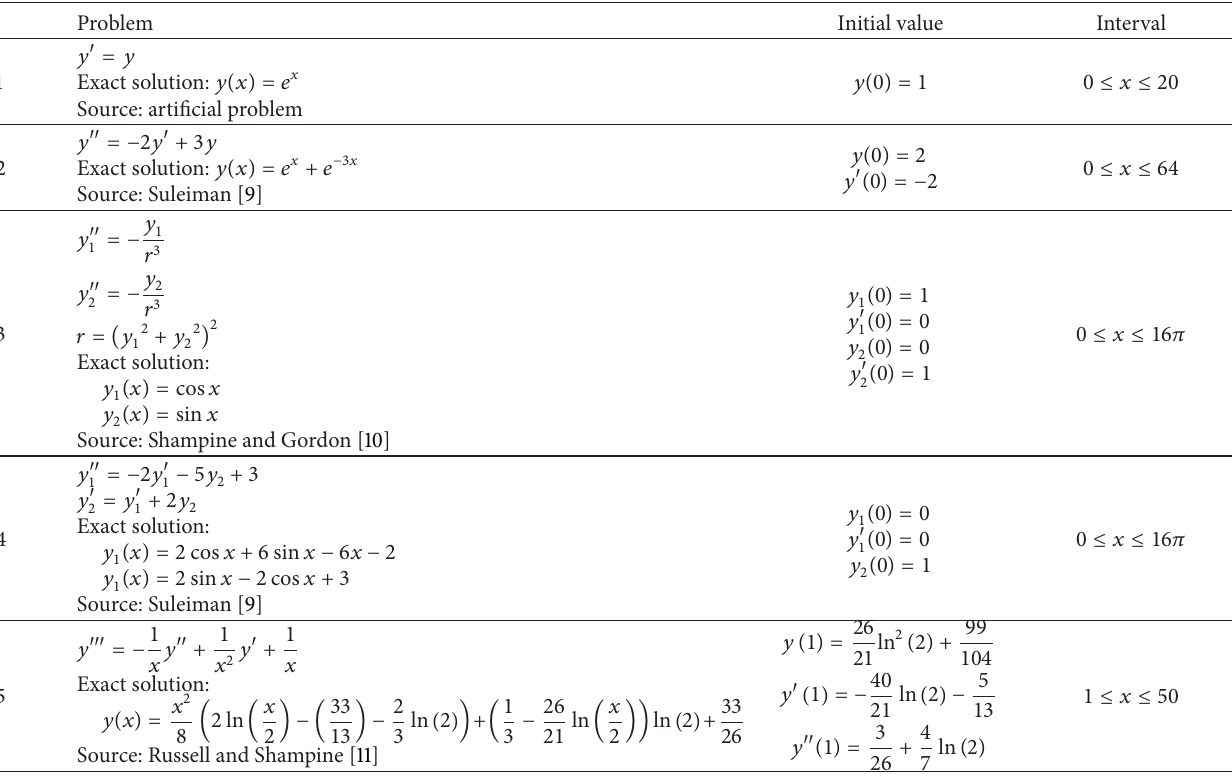
Table 3: List of test problems.